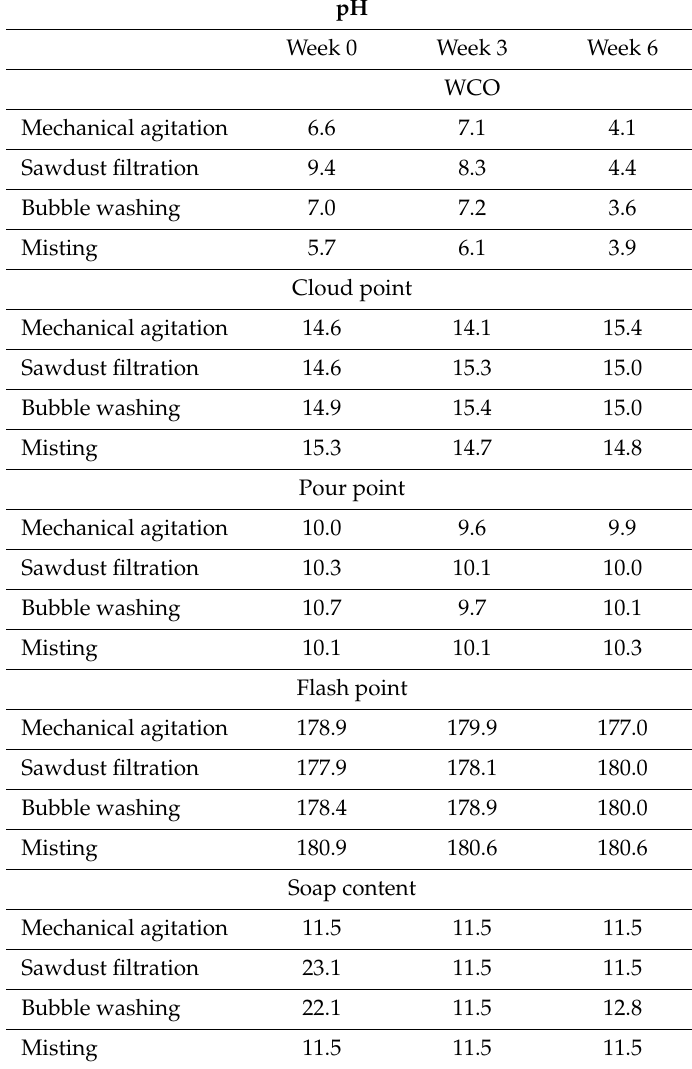
Table 1. Quality determinations for biodiesel samples during